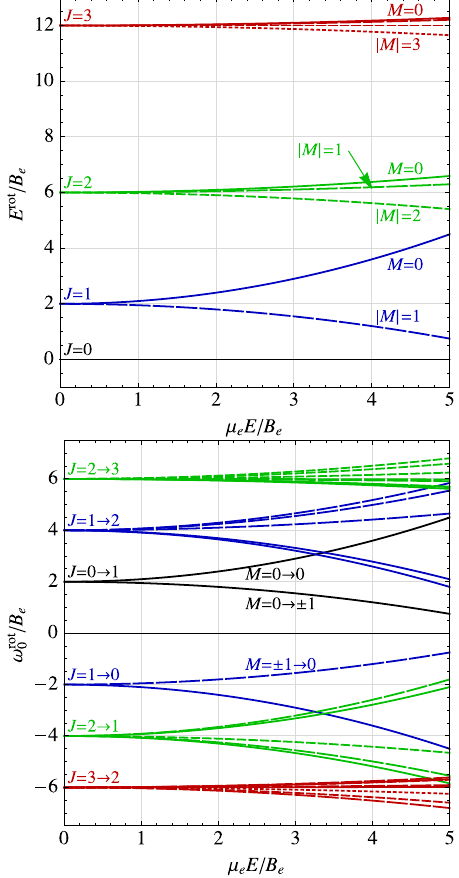
FIG. 5. Figures of Stark frequency scanning that show how = μ electric fields of order B can shift rotational transition energy e e splittings in a 1 Σ molecule by an O ð 1 Þ amount, providing continuous coverage. Top panel: Rotational energy levels E rot with quantum numbers ð J; M Þ as a function of electric field E ¼ j E j for a diatomic molecule with rotational energy constant B e and permanent electric dipole moment μ . Bottom panel: Rota- e tional energy splittings ω rot 0 for transitions with selection rules Δ J ¼ (cid:3) 1 and Δ M ¼ 0 , (cid:3) 1 (which includes E1-allowed tran- sitions), as a function of electric field E . Color coding and the dashed pattern indicate the initial state and are consistent with the top panel. Only levels with J ≤ 3 are shown; Stark shifts become less dramatic with increasing J